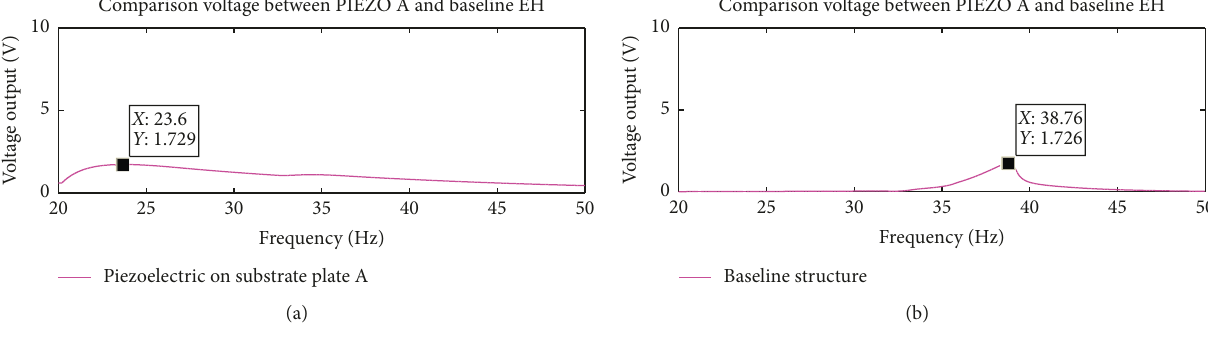
Figure 12: Voltage responses of PIEZO A and baseline EH (PIEZO A: the piezoelectric on substrate plate A; baseline EH: the baseline energy harvester).